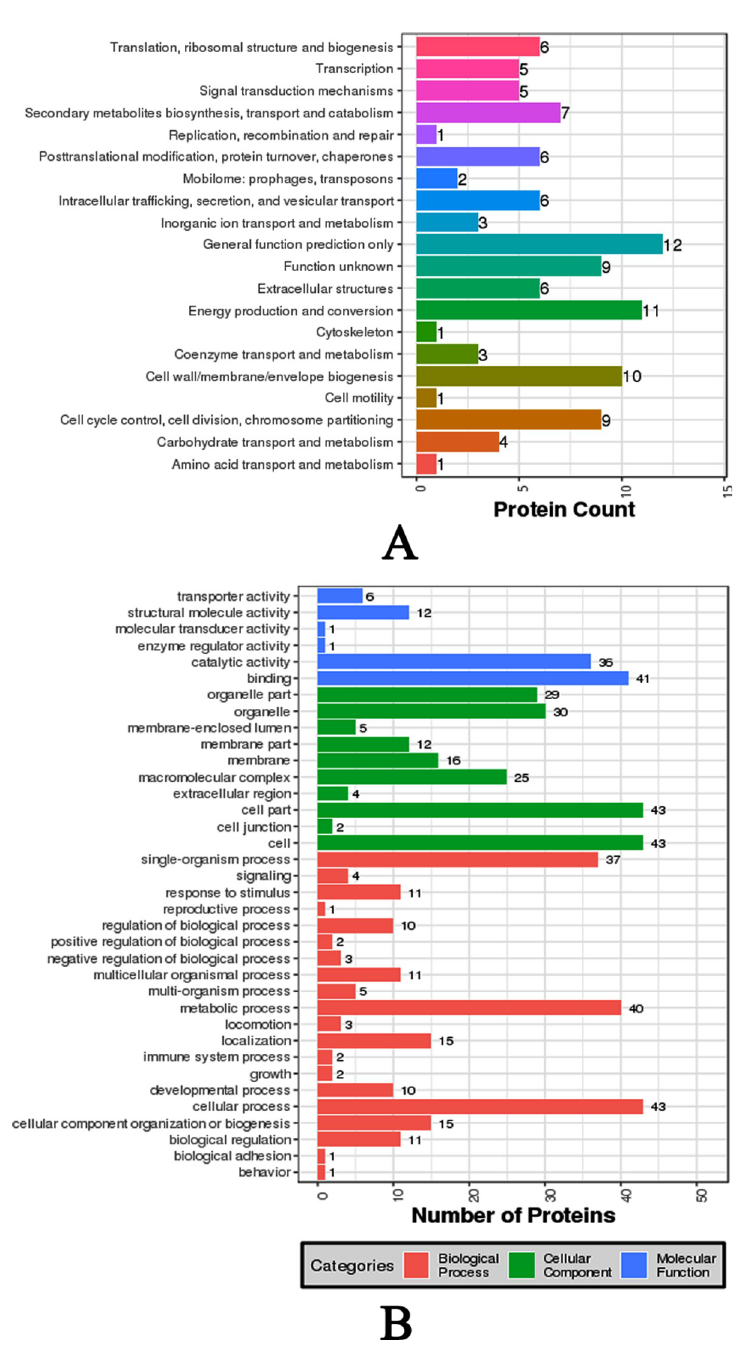
Fig 10. Functionally annotation of the myostracum SMPs identified from P . viridis shell. A : COG annotation of the SMPs from myostracum layer; B : GO annotation of the SMPs from myostracum layer. pulling force up to 10 kg [33], indicating the high strength, strong adhesion and toughness, and long fatigue lifetime of the adductor muscle–shell interface. In the AMS region of the P . viridis shell, the myostracum layer is exposed to the inner shell surface and connected directly with the adductor muscles (Fig 1C), suggesting the important roles of the myostracum layer in muscle-shell attachment as well as in the strength of the shell.